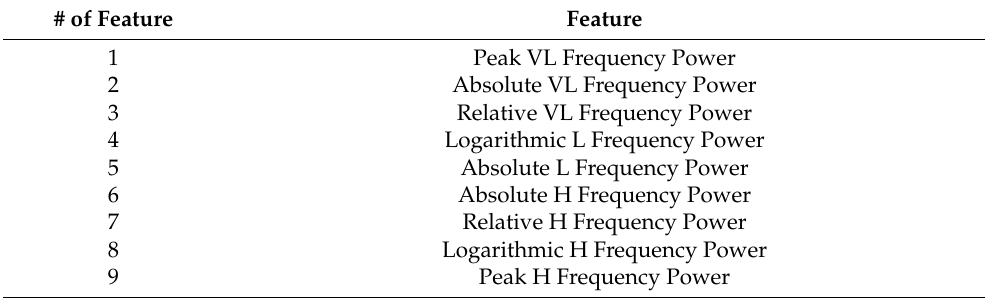
Table 9. Significant features in frequency-domain using the Lomg–Scargle method.